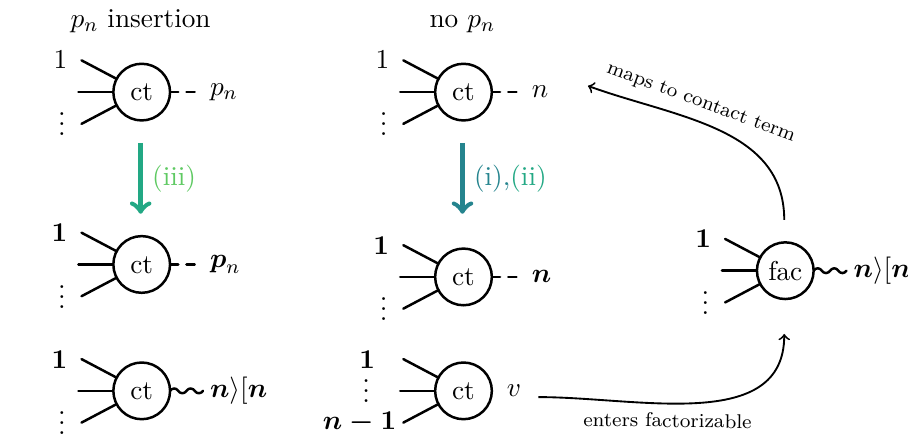
Figure 6 . The low-energy factorizable contributions featuring a longitudinal vector (bottom right) map to high-energy contact terms (top right) without affecting the determination of massive low- energy contact terms featuring a longitudinal vector (bottom